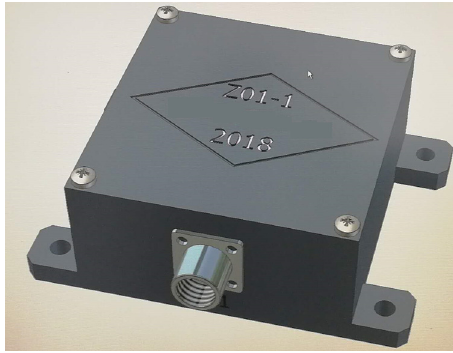
Figure 2: The structure diagram of the dosimeter. Figure 3: Total radiation dose of each